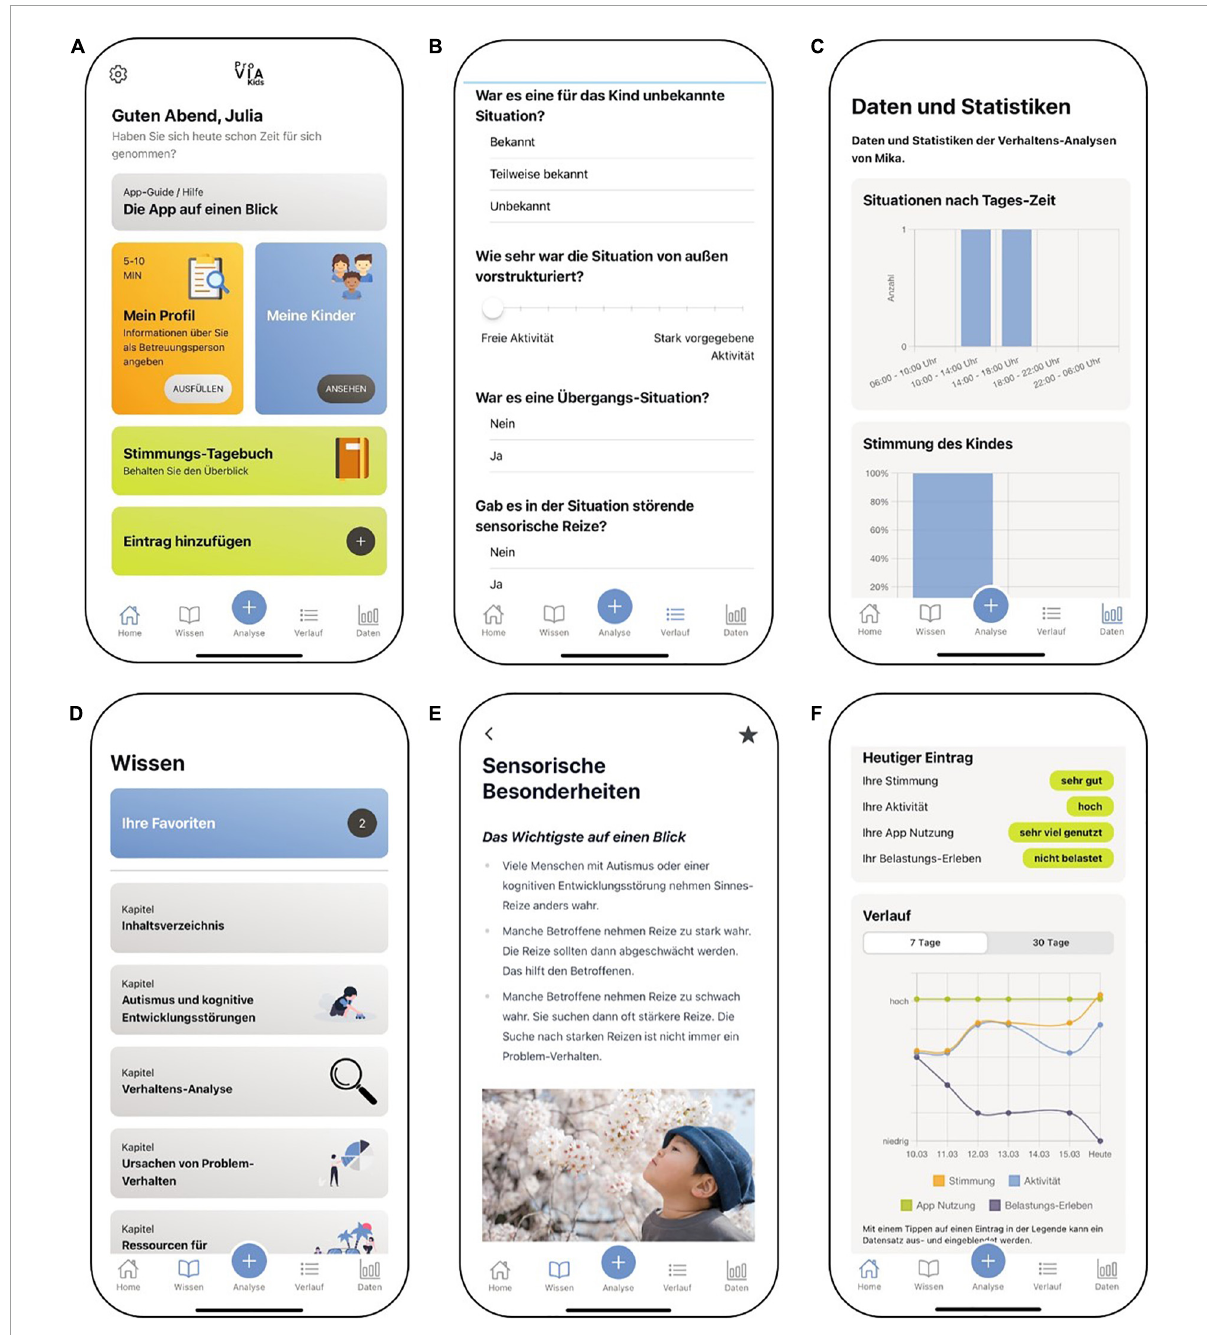
FIGURE3 Features of the ProVIA-Kids app (original German version): (A) Home screen, (B) Behaviour analysis algorithm, (C) Graphical display of the frequency of individual contributing factors for CB, (D) Menu for psychoeducational content, (E) Sample from chapter “Hypersensitivity” with recommendations for caregivers, (F) Mood